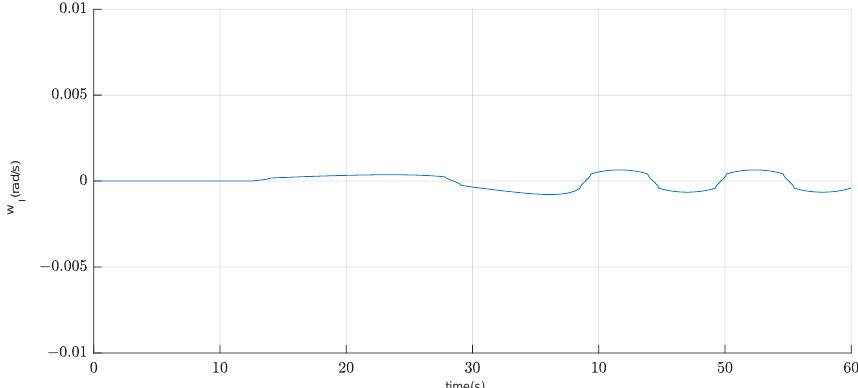
Figure 22. The variation curve of ω l for the leader during the movement.